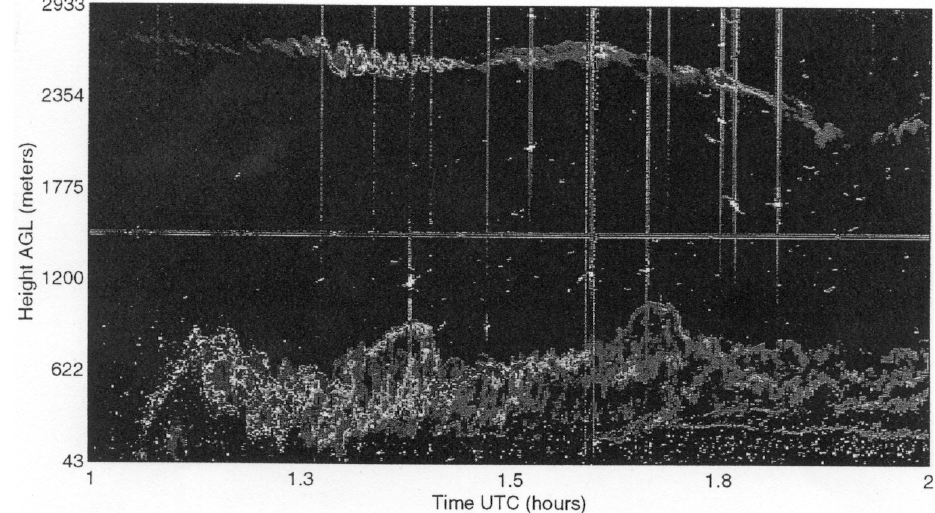
Fig. 4. Another FMCW radar image of low level turbulence, in this case, showing frontal turbulence with no sign of K-H billows (again adapted from Eaton et al., 1995). The entire picture covers a period of one hour in duration, and covers the height range from a 40 metre altitude to 1.8 km altitude.